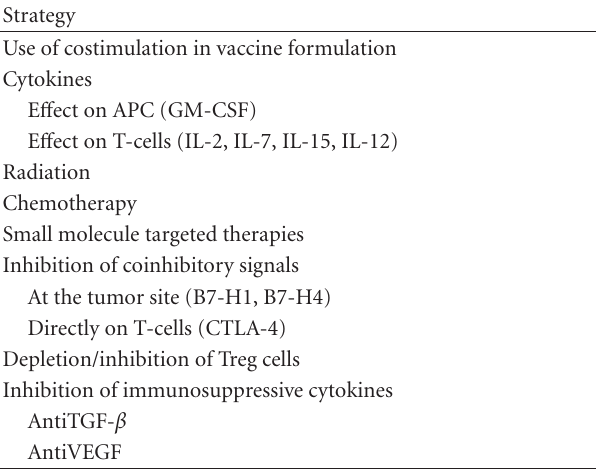
Table 3: Strategies to enhance antitumor T-cell responses ∗